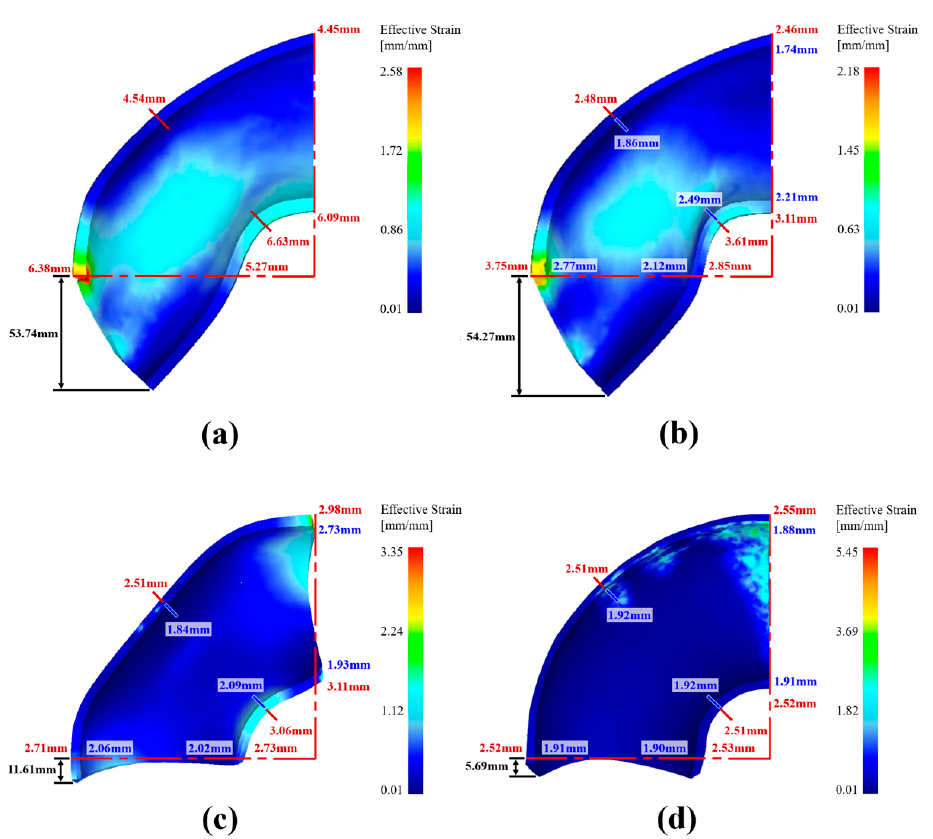
Figure 5. Predicted shape of elbow using forging analysis contained experiments. ( a ) the deformation of the single pipe condition made of the DSS without mandrel; ( b ) the deformation of bi-metal pipes The bottom geometry of the formed products according to the cutting angle of the initial condition; the deformation geometry depending on the setting of other forming conditions ( c , d billets demonstrated that the tip of the top-right part was bent by up to 5.8 mm to the left when pressurized with the punch. While the right part was not cut, deformation on the top right part occurred more as the length ratio decreased. In addition, for the left part of